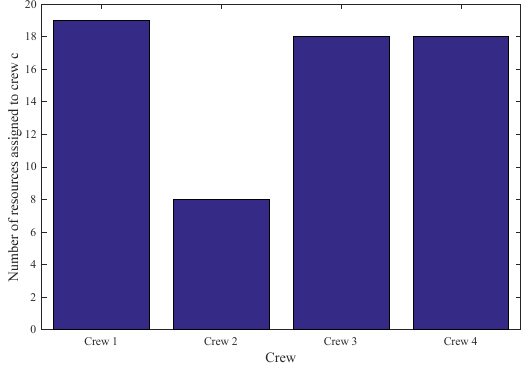
Figure 6. The optimal number of resources is assigned to each crew in the 34 bus case.